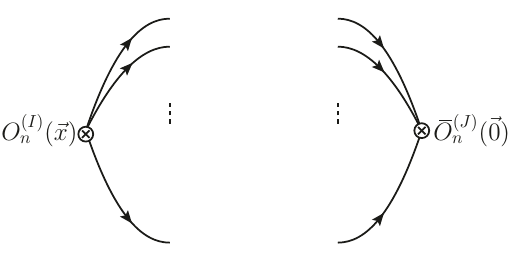
Figure 2 : The diagram representing the insertion of a chiral operator O ( I ) n from the I -th node in ~x and of the anti-chiral operator O ( J ) from the J -th node in the origin. The n number of propagators connecting the insertion points is n